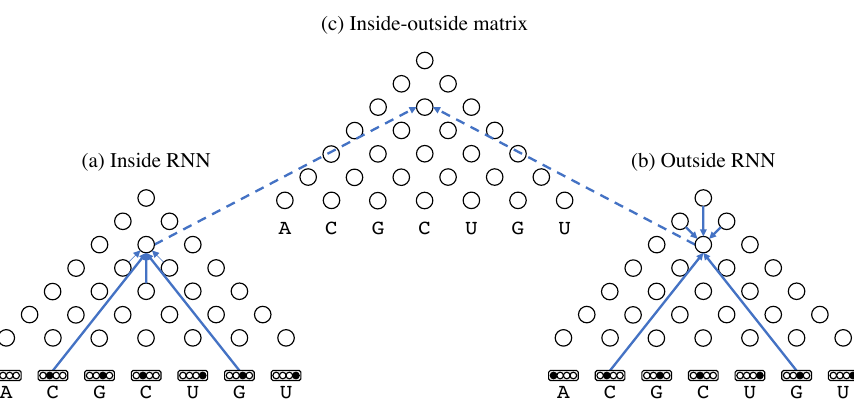
Figure 2. A bidirectional recursive neural network for calculating base-pairing probabilities. A set of four dots above each base represents the one-hot representation of the base. Each circle indicates a network layer with 80 hidden nodes. Each solid arrow indicate a connection between layers along grammatical trees derived from the RNA grammar. Each dashed arrow represents a connection that aggregates the inside and outside layers to output base-pairing